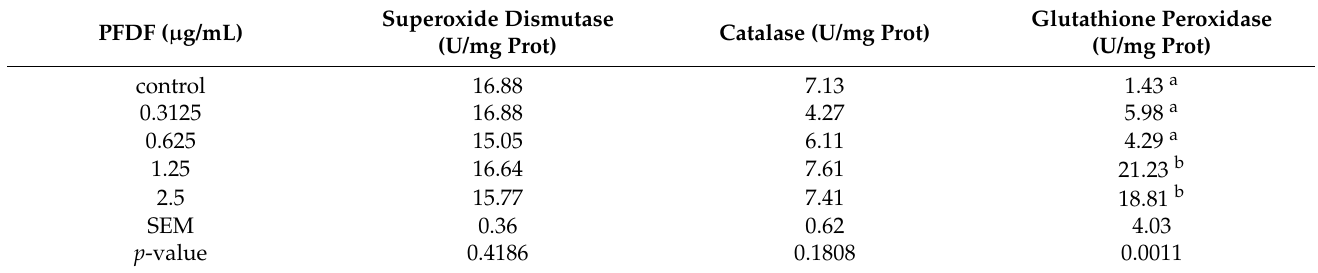
Table 4. Effect of PFDF on the antioxidant enzyme activities of zebrafish